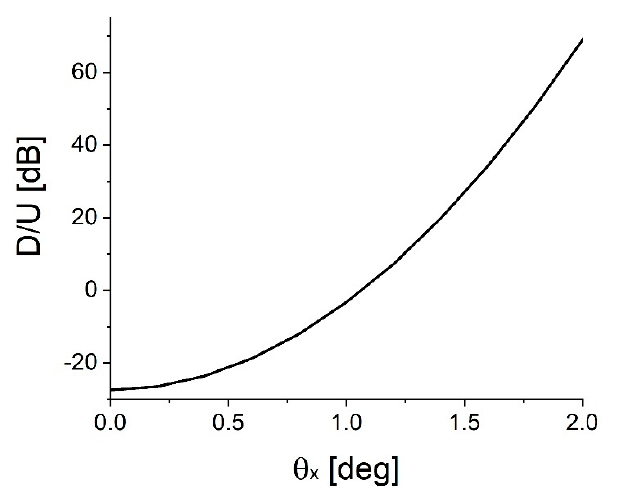
Figure 13. Interference model [32].